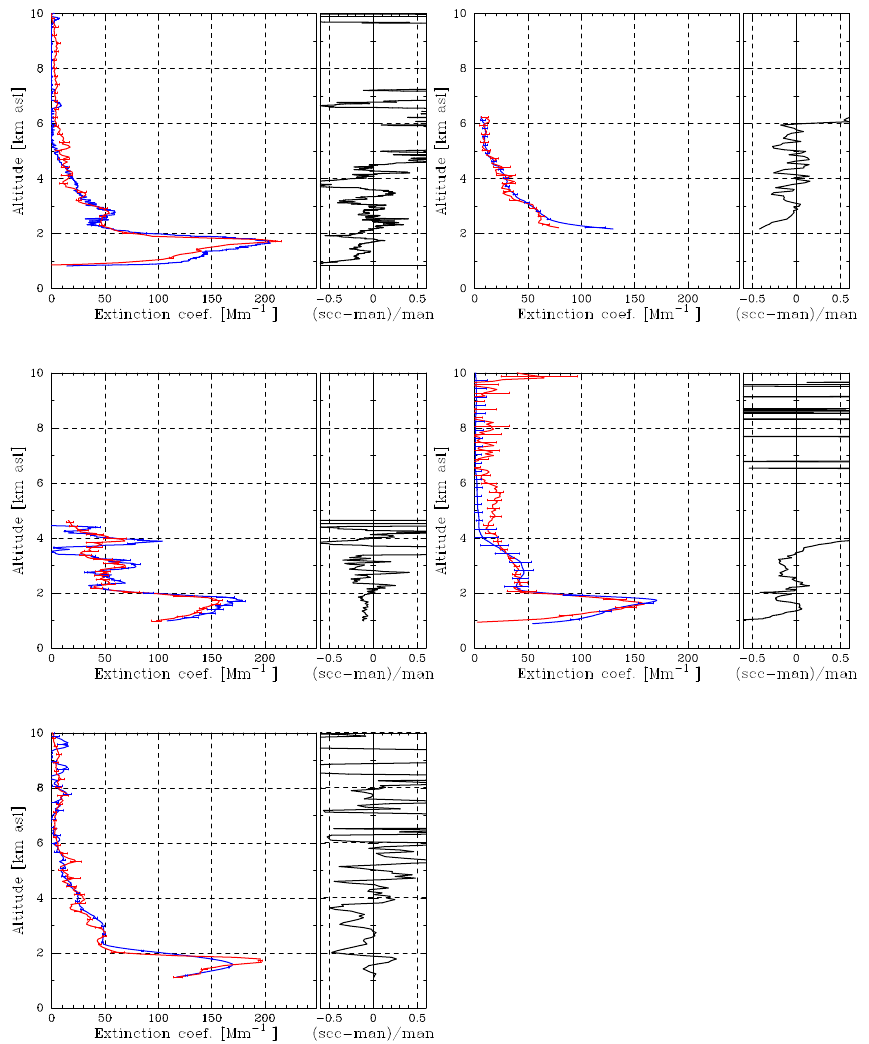
Figure 7. Comparison of extinction coefficient profiles at 355nm derived with the Raman method for five lidar systems participating in the EARLI09 inter-comparison campaign. All profiles refer to the measurement session taken from 21:00 to 23:00UT on 25 May 2009, and they have been retrieved using the N 2 Raman backscatter signals at 387nm. The profiles in blue are the analyses provided by the originator of the data using his/her own analysis software. The profiles in red are the ones retrieved by the SCC. From left to right, upper panel: RALI, MARTHA; middle panel: Polly XT , MSTL-2; bottom panel: